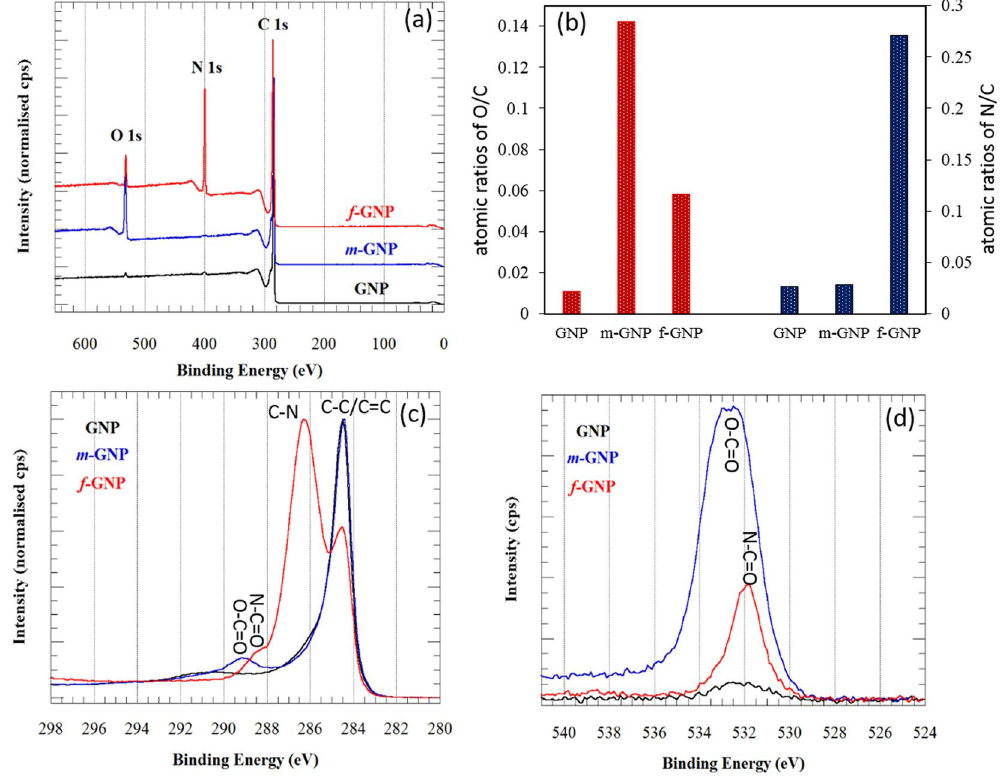
Figure 4. X-ray photoelectron spectra measured on the various samples; survey spectrum ( a ), O/C and N/C atomic ratios when C/C was considered to be 1 ( b ), C 1 s ( c ), and O 1 s ( d )